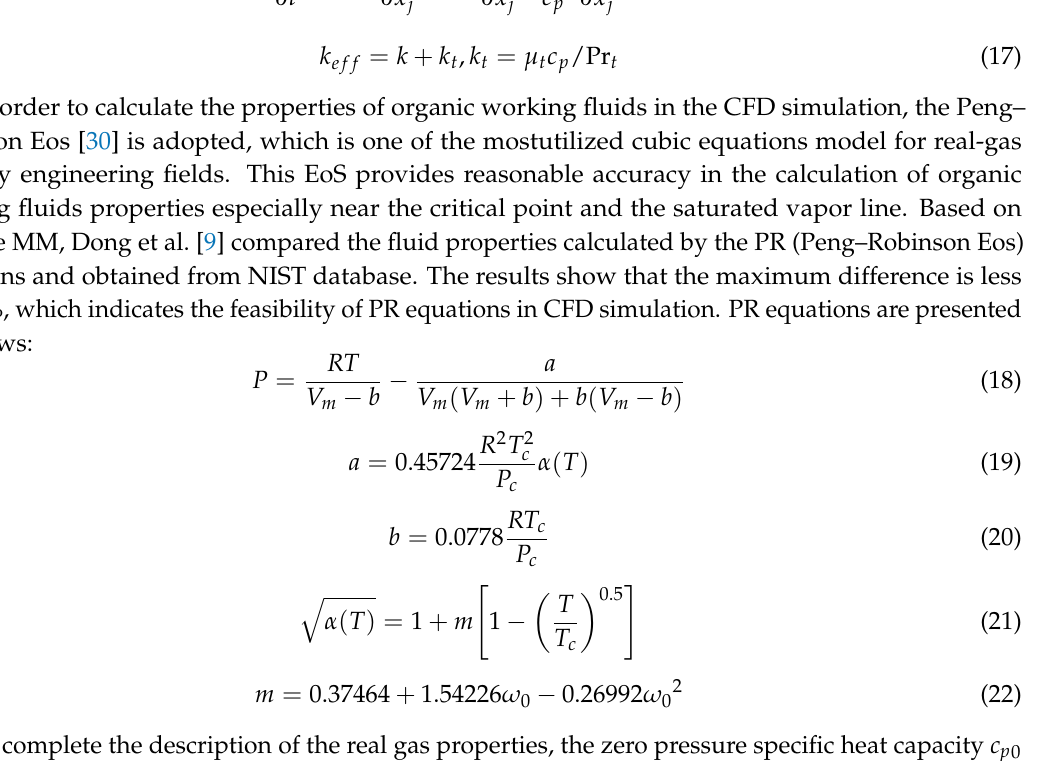
Figure 4. The unstructured mesh around the stator blade. 2.5x10 4